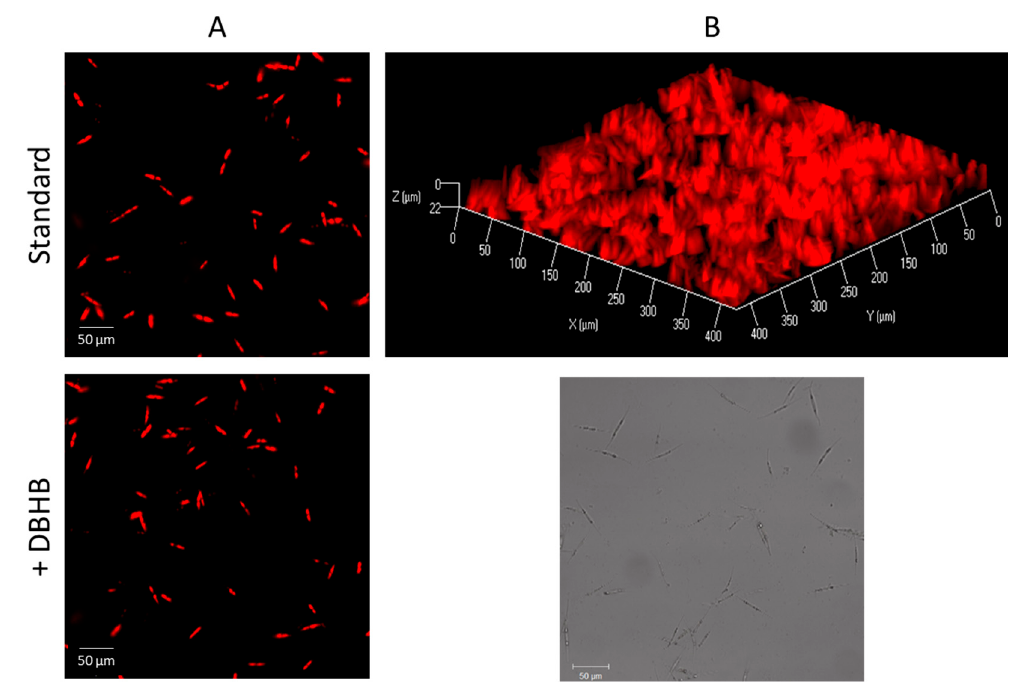
Figure 4. Effect of DBHB (16 μ M) on: ( A ) C . closterium adhesion, scale bar: 50 μ m (24 h); and ( B ) biofilm maturation (24 h). CLSM images represent adhered cells on the glass slide without the presence of DBHB (standard on the top of the panel) and in the presence of DBHB (at the bottom). After 24 h in presence of medium flow (150 μ L/min) containing DBHB (16 μ M), no diatom